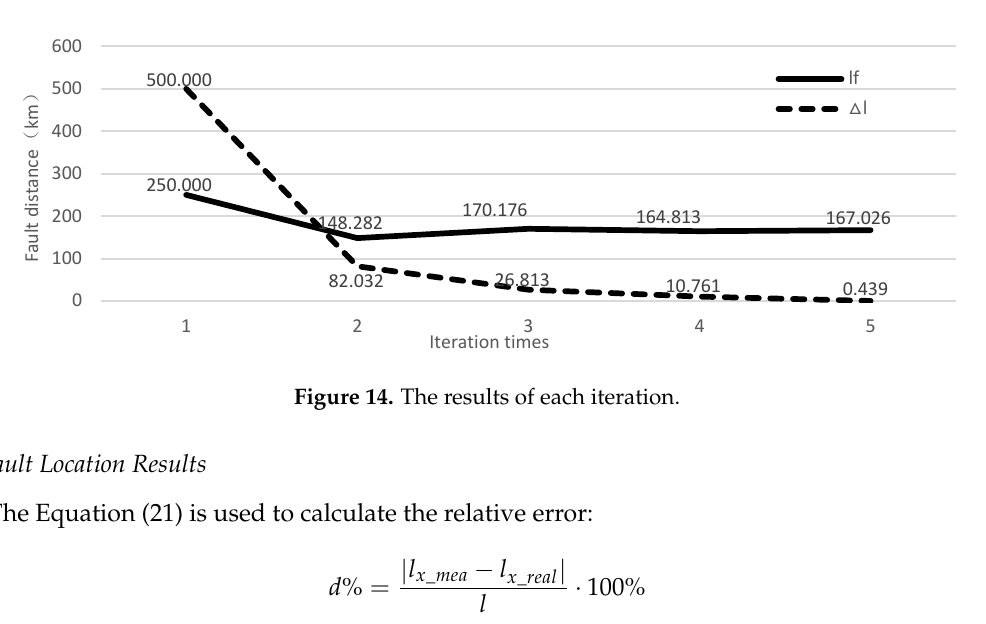
Figure 13. Time difference at terminals. ( a ) Terminal L ( b ) Terminal R.